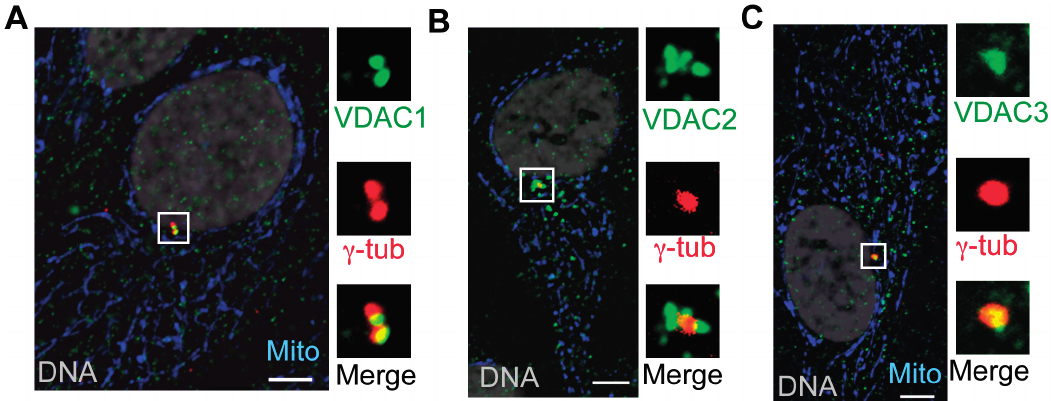
Figure 2. All three VDACs localize to centrosomes. ( A – C ) Representative images of asynchronously growing human RPE1 cells stained for γ -tubulin ( γ -tub; red), mitochondria (Mito, blue), and ( A ) VDAC1 (green); ( B ) VDAC2 (green); and ( C ) VDAC3 (green). DNA is stained by Hoechst (gray). In this and other figures, panels show four-fold digitally magnified images of a region of interest, in this case surrounding the centrosomes. Bar = 5 μ